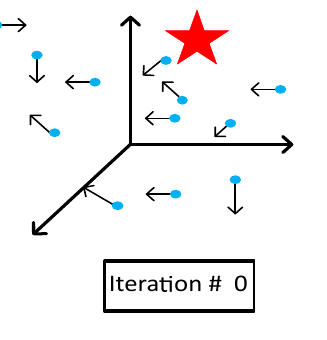
Figure 2. Swarm of